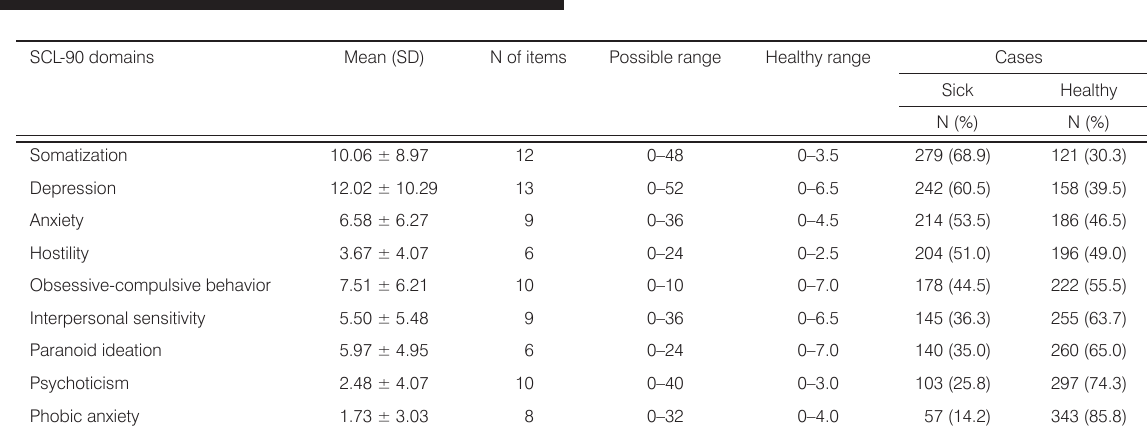
Table 2. The mean scores of SCl-90-R dimensions and frequency of participants’ psychological